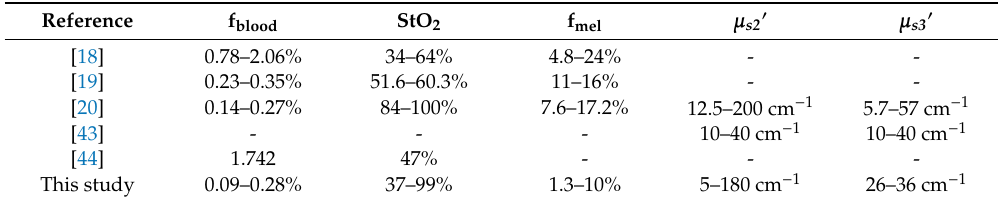
Table 4. The comparison of optical parameters estimated from this study to those from in-vivo studies reported in the literature.